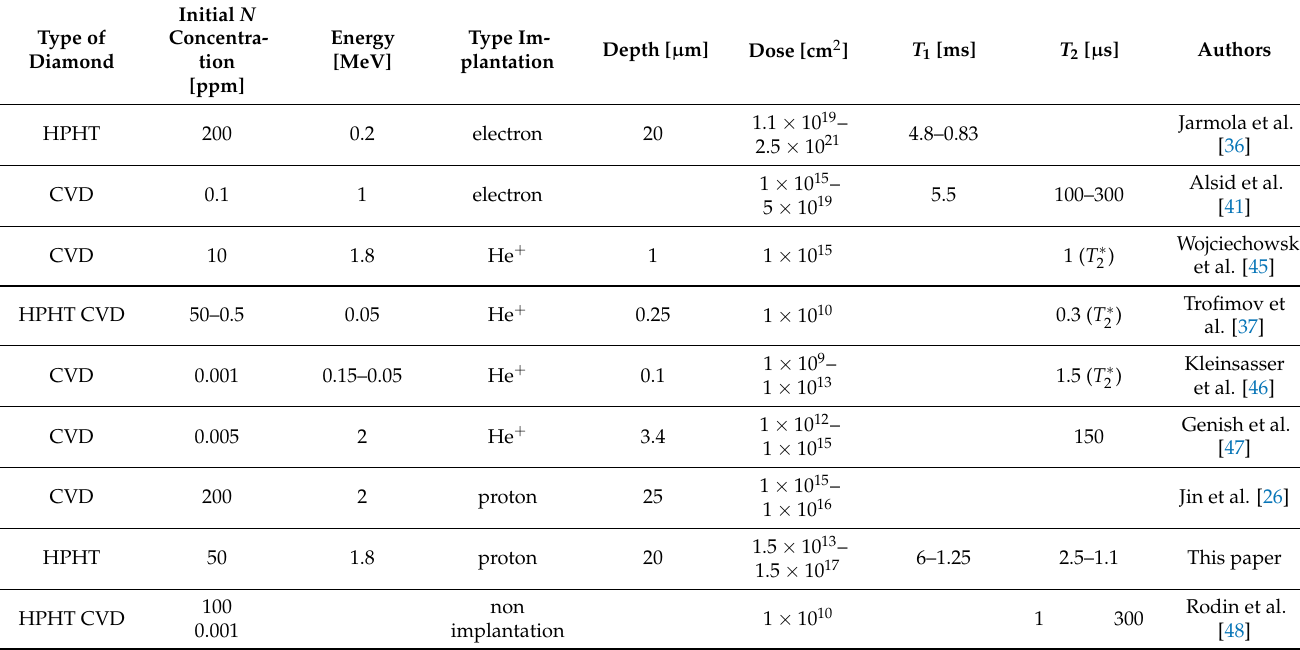
Table 2. Table comparing type of diamond, initial N concentration, energy of incident particles, type of implantation, depth of penetration, dose, value of longitudinal, and transverse relaxation time for selected